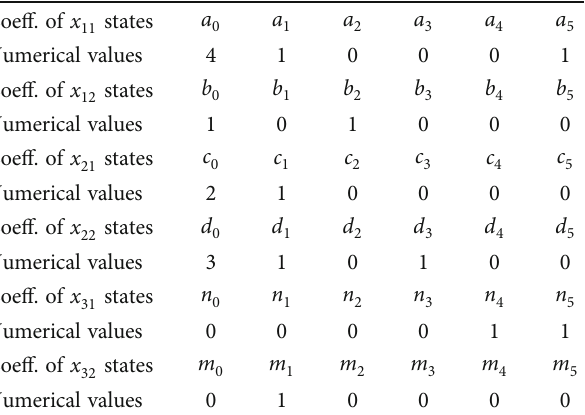
Table 2: Unknown coe ffi cients of the representation of x ð t Þ Þ , x 3